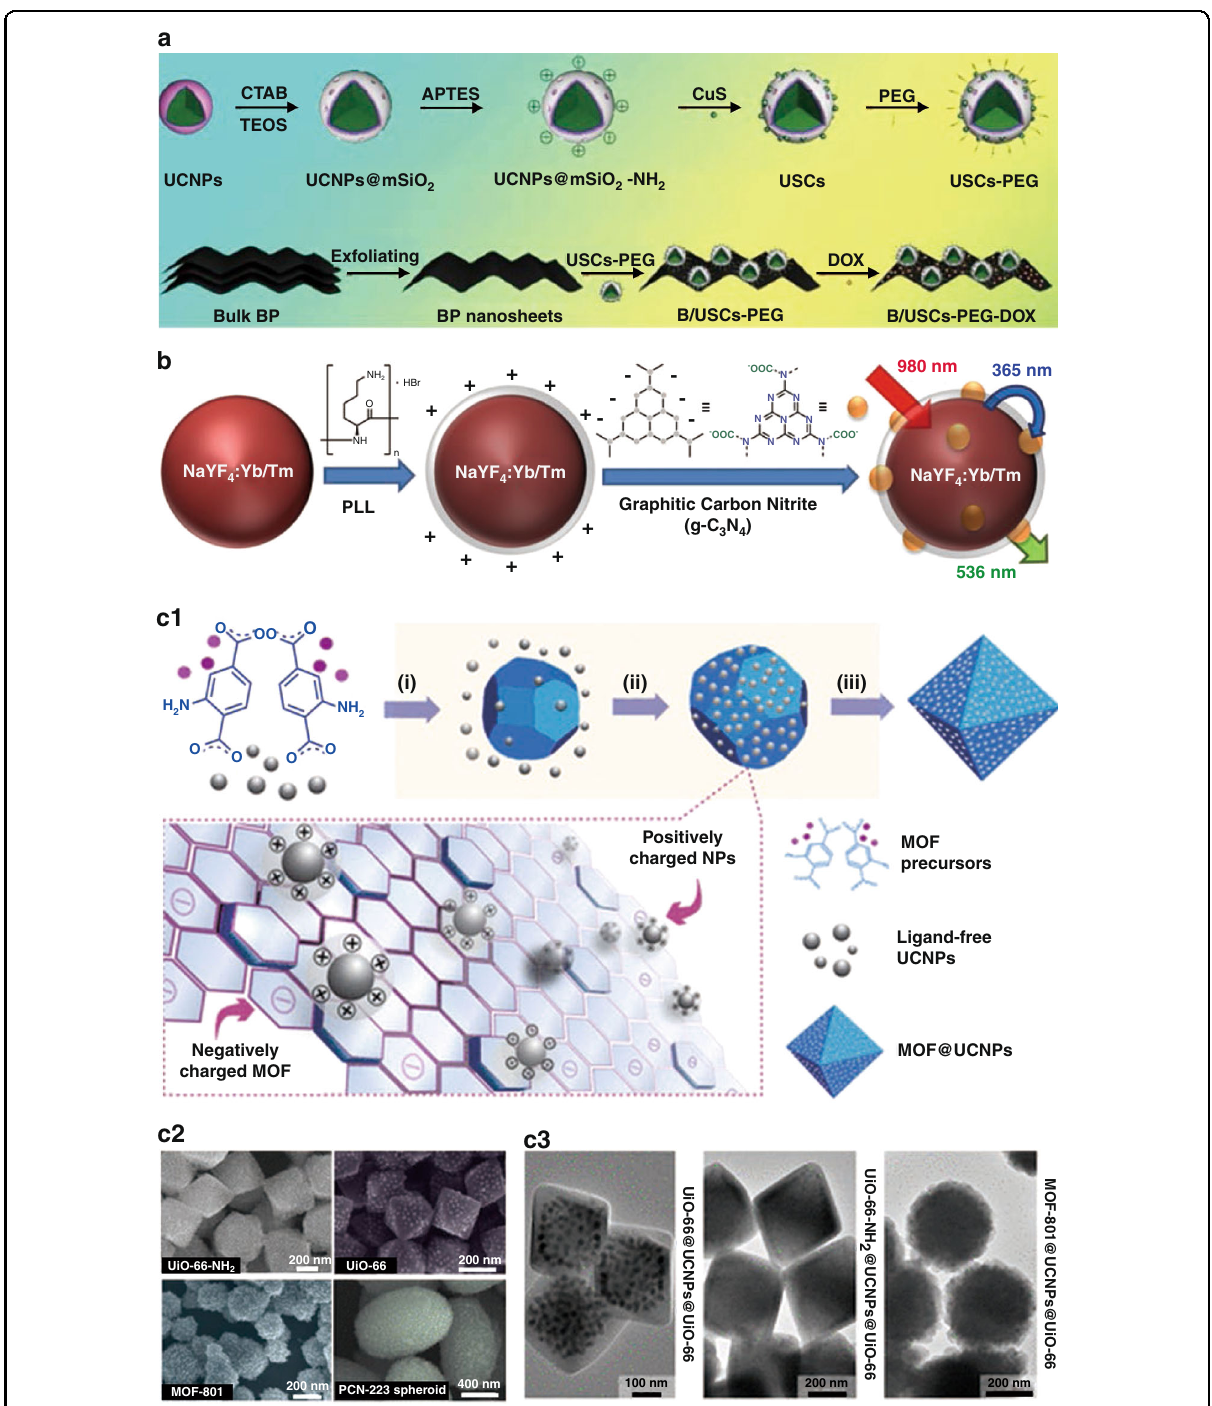
Fig. 2 Electrostatic adsorption technique. a Schematic diagram of the synthetic process of B/USCs-PEG-DOX 24 . b Schematic illustration of the preparation of NaYF 4 :Yb/Tm-PLL@g-C 3 N 4 25 . c1 Schematic of the synthetic process of UCNPs and MOF nanocomposites. c2 SEM images of UiO-66-